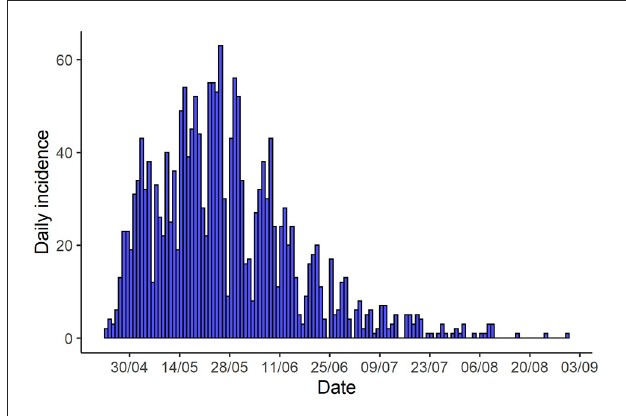
FIGURE1 Time series of the number outbreaks (farms) detected per day in the 2001 epidemic by date of report.